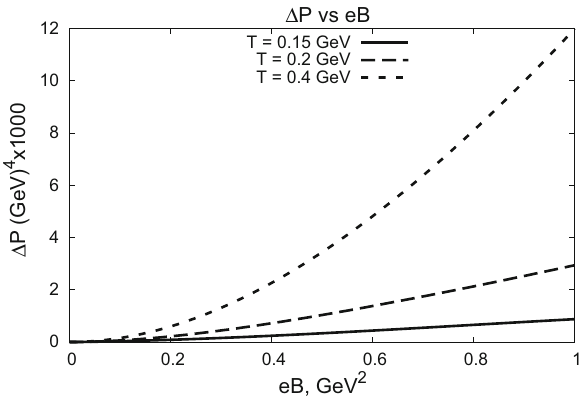
Fig. 1 The dependence of (cid:12) P ( T , B ) on eB for fixed T = 0 . 15 , 0 . 2 , 0 . 4 GeV. (cid:12) P demonstrates quadratic behaviour ∼ ( eB ) 2 for eB < 0 . 5 GeV 2 and linear behaviour ∼ ( eB ) for > 0 . 5 GeV 2 according to (13)